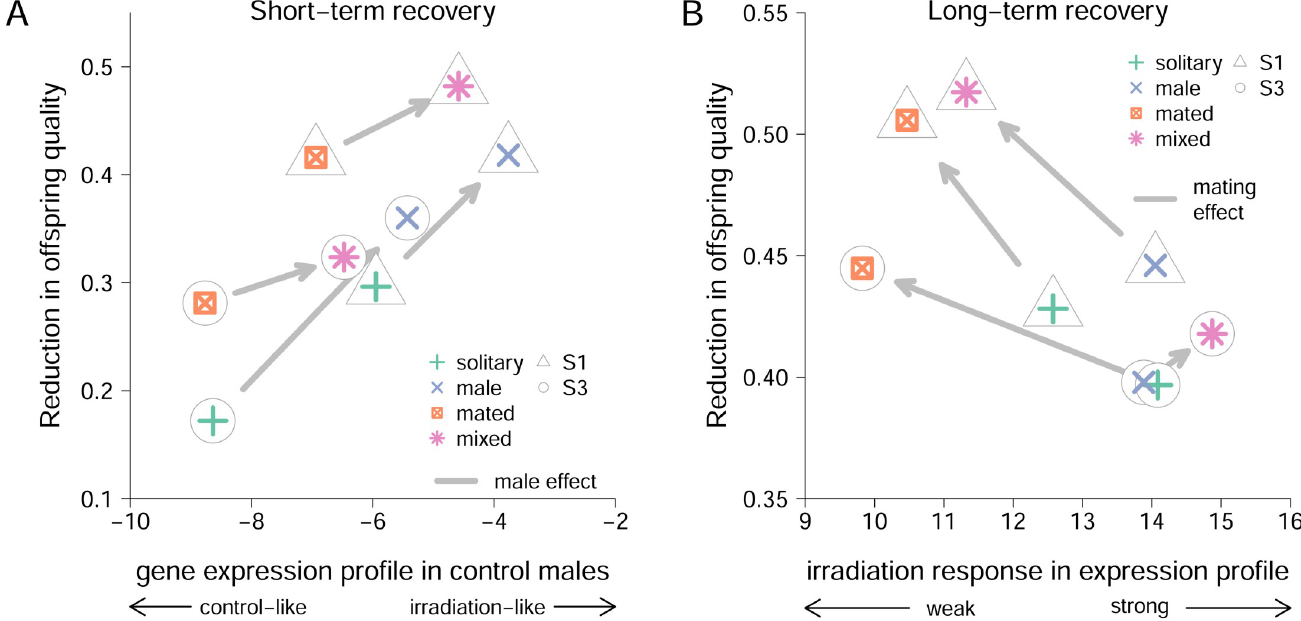
Fig 5. Relationship between gene expression profiles in fathers and the reduction in the quality of offspring fathered by irradiated males. (A) As indicated by the first dimension of the canonical correlation analysis (see Fig 4), stronger reduction in offspring quality after a short-term recovery is associated with a more irradiation-like gene expression profile in control males (corresponding to baseline expression in sociosexual treatments before irradiation), with male–male interactions leading to more irradiation-like gene expression profiles and stronger reduction in offspring quality. Arrows indicate the effect of adding males to the sociosexual environment. (B) According to the second canonical dimension, larger gene expression response to irradiation (seen in unmated males) led to a smaller reduction in offspring quality. Arrows indicate the effect of adding females (and thus mating opportunities) to the sociosexual environment. The data underlying this figure can be found in “MainExp_Log2cpm_IrradiationGenes.txt,” “QualityReduction_Short_Means.txt,” and “QualityReduction_Long_Means.txt” at Mendeley Data